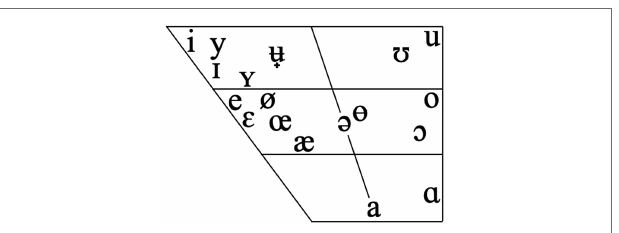
FIGURE 1 | The Swedish vowels used in the transcription. Vowels not recognizable as any of those phonemes were marked as “V.” Adapted from IPA Chart from International Phonetic Association.